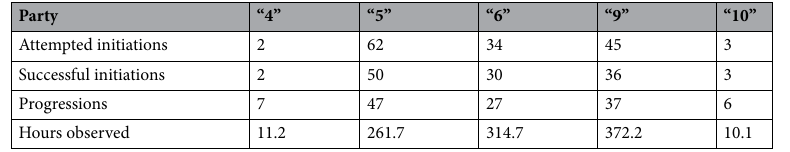
Table 2. Number of attempted and successful initiations collected per study party. The number of progressions that involved part or all of each study party. The number of hours observer D.M. spent with each party in 2016 and 2017. The main study parties were “5”, “6”, and “9”.